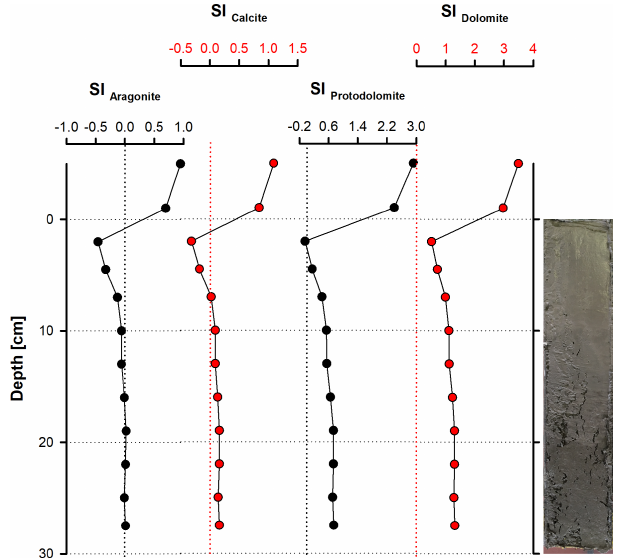
Figure 10. Saturation indices (SIs) of selected carbonate mineral phases. It can be noted that all phases are clearly supersaturated in the water column but close to saturation throughout most of the sediment column (except for the uppermost